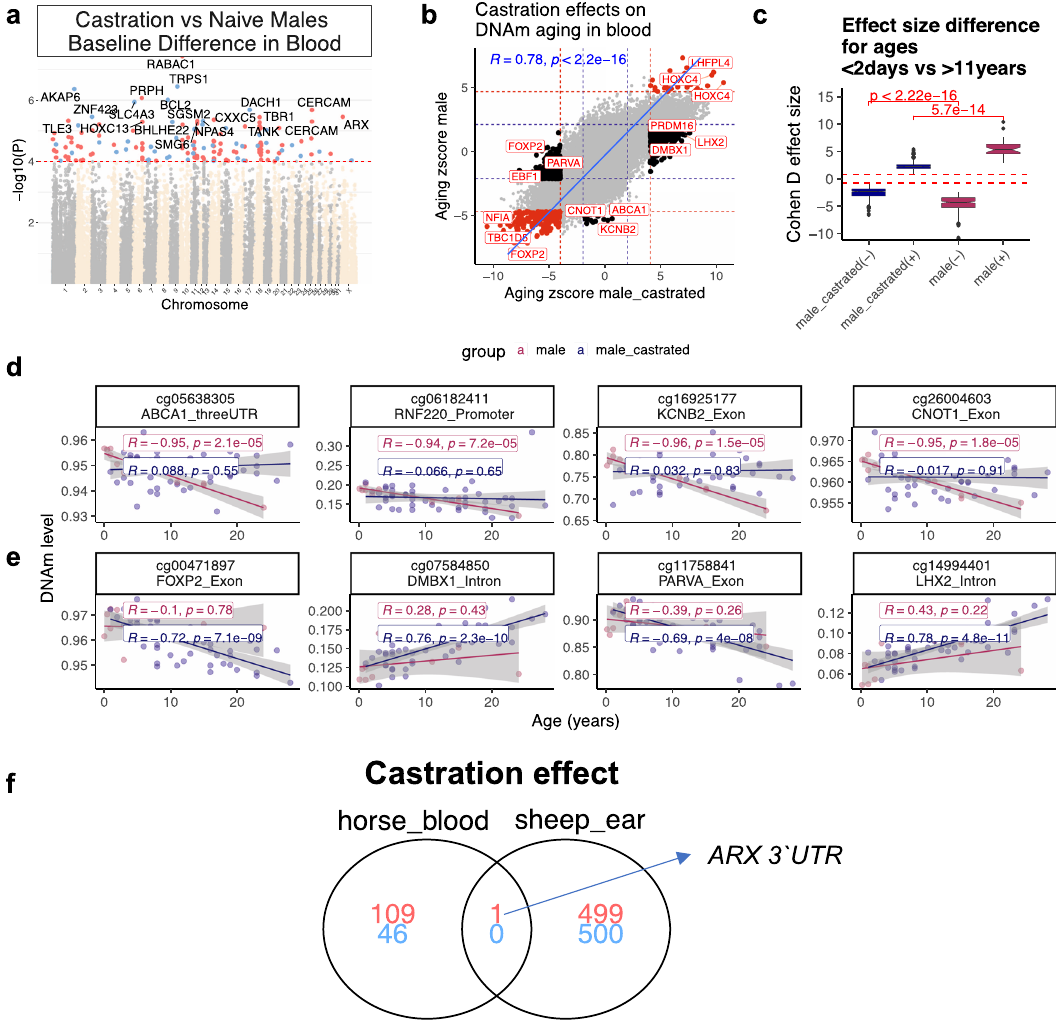
Fig. 4 Castration moderately alters DNAm pro fi le of horse blood. a Manhattan plots of the EWAS of castration, in the blood of male horses. Statistics: Multivariate linear regression model whose dependent variables are CpGs and whose co-variates are castration status and chronological age. Sample size: geldings, 48; stallions, 10. The coordinates are estimated based on Equus_caballus.EquCab3.0.100 genome assembly. The direction of associations with p < 10 − 4 (FDR < 0.02, red dotted line) is highlighted by red (increase) and blue (decrease) colors. Top 15 CpGs ( p < 4.7e − 6, FDR < 0.008) were labeled by the neighboring genes. b Sector plot of aging effects on blood methylation levels by castration status in male horses. The Z statistics result from applying the Fisher z-transformation to the Pearson correlation between CpG and age. Red-dotted line: p < 10 − 4 ; blue-dotted line: p > 0.05; Red dots: age-related CpGs not affected by castration; black dots: CpGs whose aging pattern differs between geldings and stallions. c The effect size of age on DNAm is larger in blood of naïve vs the castrated male horses. The effect size is calculated by Cohen D method between age groups <2 days vs. >11 years horses. Only the top 1000 signi fi cant CpGs per tissue (500 per direction) are presented in the box plot. ( + ) and ( − ) indicate the direction of change for each group. The dashed red line indicates Cohen d > |0.8 | , which means a large effect size. d , e Scatter plots of selected CpGs that change with age only stallions ( d ), or geldings ( e ) blood. The red dots and blue dots in the scatter plot correspond to blood samples from geldings and stallions, respectively. The shading visualizes the 95% con fi dence band of the linear regression model. R : Pearson correlation coef fi cient. These relationships require validation in new data and also a consideration for a potential confounding effect of horse breeds. f The overlap of castration methylation signatures between horse blood and sheep ears 40 . Although we considered the top 1 thousand signi fi cant CpGs in sheep (500 in each direction), we only found one overlapping